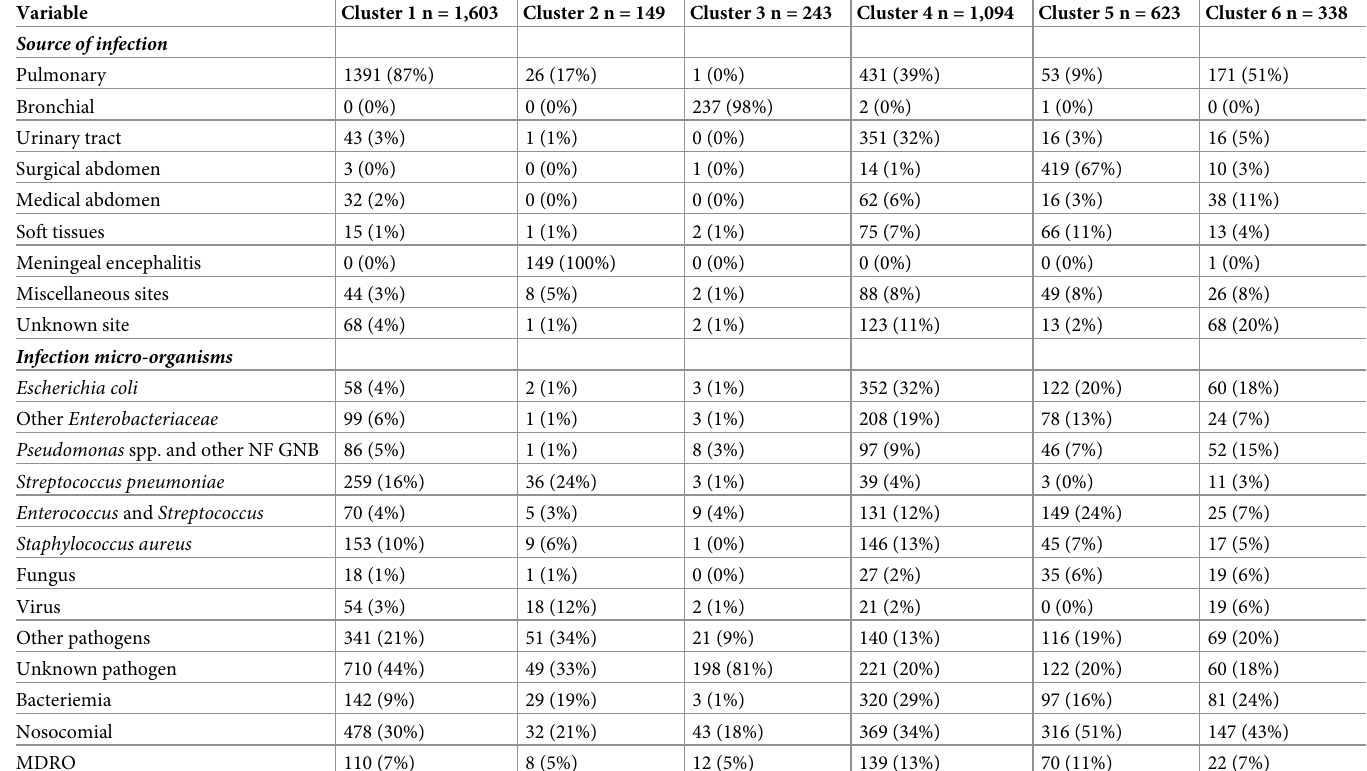
Table 2. Source of infection and micro-organism by cluster (performed in training set).